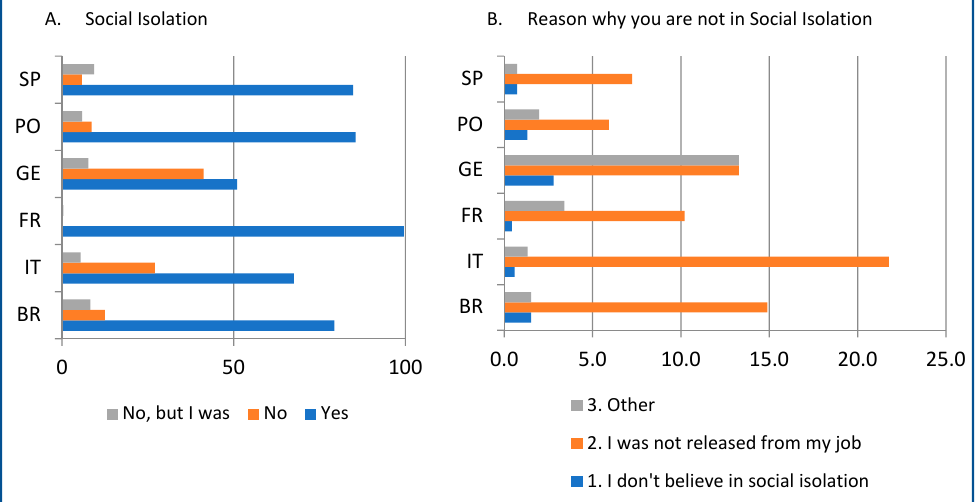
Figure 1. Number of individuals (%) in social isolation ( A ) and reasons why the individual was not isolated ( B ). Sample constituted by general population aged from 18 years old from Brazil ( n = 1845), Italy ( n = 680), France ( n = 236), Germany ( n = 143), Portugal ( n = 152), and Spain ( n = 138). Legend: BR, Brazil; IT, Italy; FR, France; GE, Germany; PO, Portugal; SP,